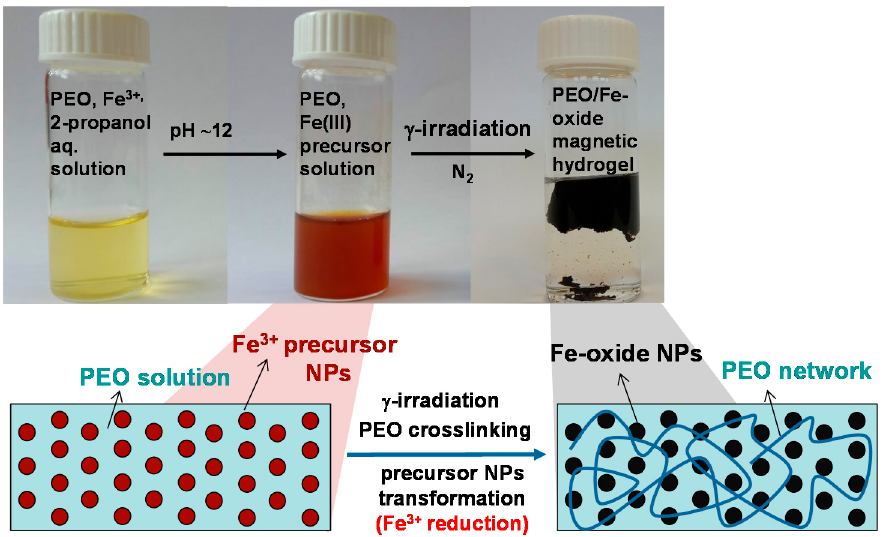
Figure 1. Schematic presentation of the synthesis procedure of magnetic poly(ethylene oxide) (PEO)/iron oxide nanocomposite hydrogels.